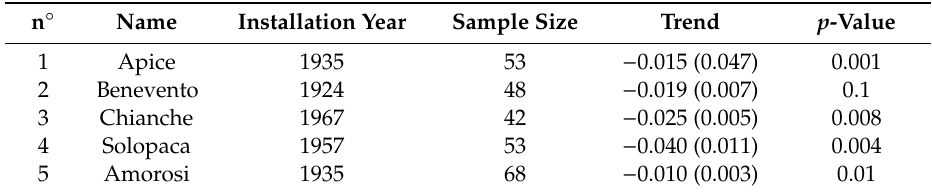
Figure 1. Map showing the study area. Rivers (light blue lines) and cross sections (brown lines) used for reconstructing the wDEM are shown in the map. Red symbols depict hydrometric stations considered in the analysis: 1-Apice, 2-Benevento, 3-Chianche, 4-Solopaca, 5-Amorosi. The validation area is shown as well as UTM 33 N coordinates. Table 1. Results from linear regression-based trend analysis. Standard error of estimated parameters is reported in parentheses.